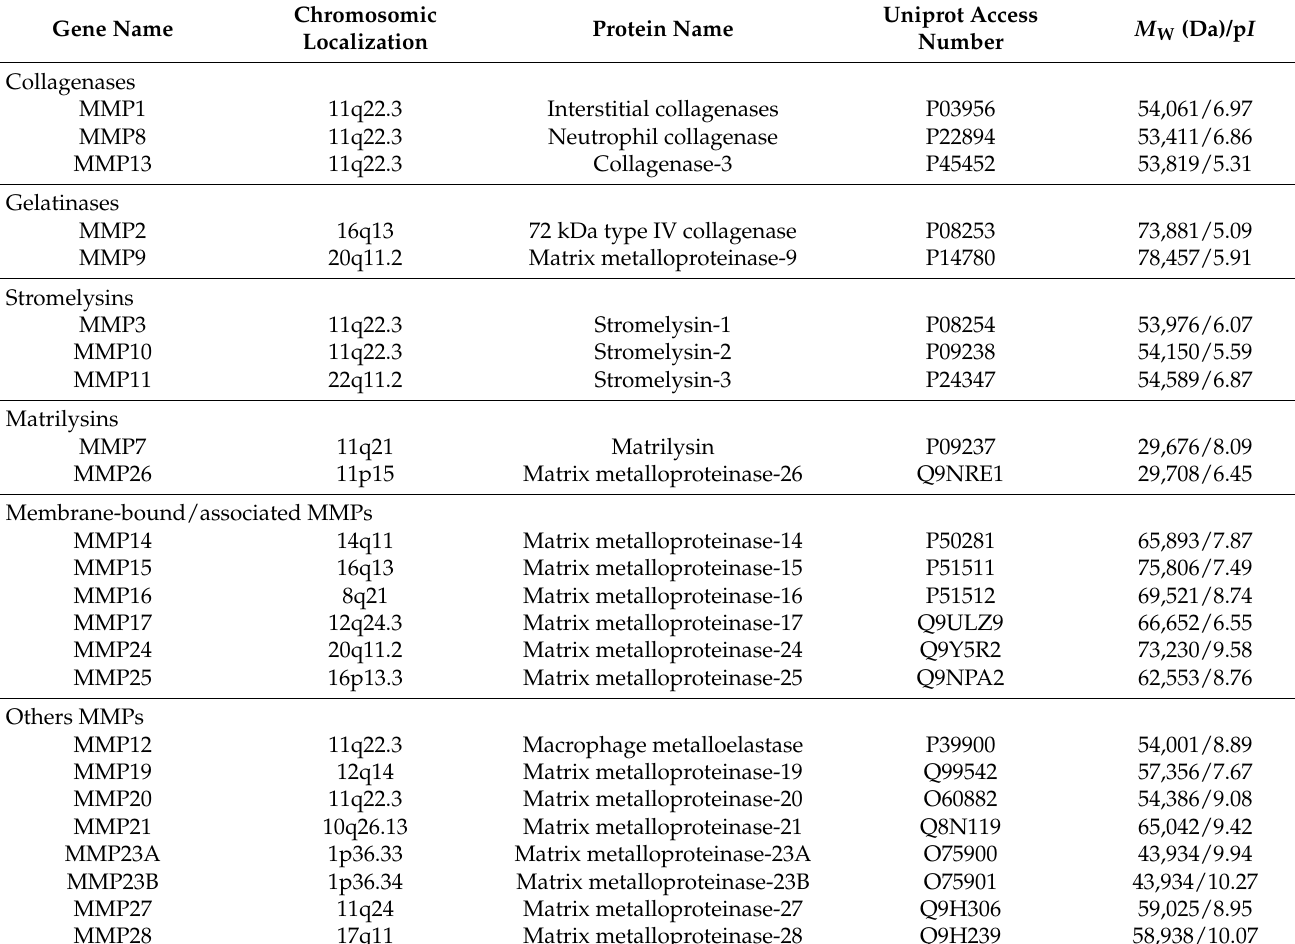
Table 1. List of 24 MMPs classified into 6 sub-families according to their substrate specificity (collagenases, gelatinases, stromelysins, matrilysins, mmbrane-bound/associated MMPs, and other MMPs). For each MMP, the gene name, chromo- somic localization, protein name, uniprot database access number, theoretical molecular weight ( M W ) and isoelectric point (p I ) are